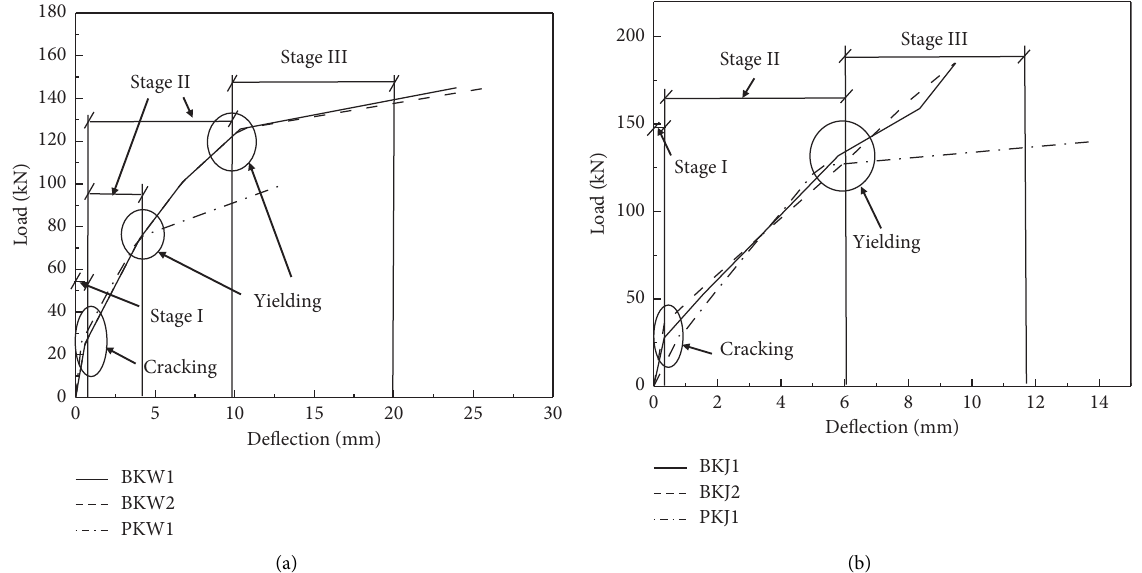
Figure 6: Load-deflection curves of all tests: (a) flexural beams; (b) shear beams.